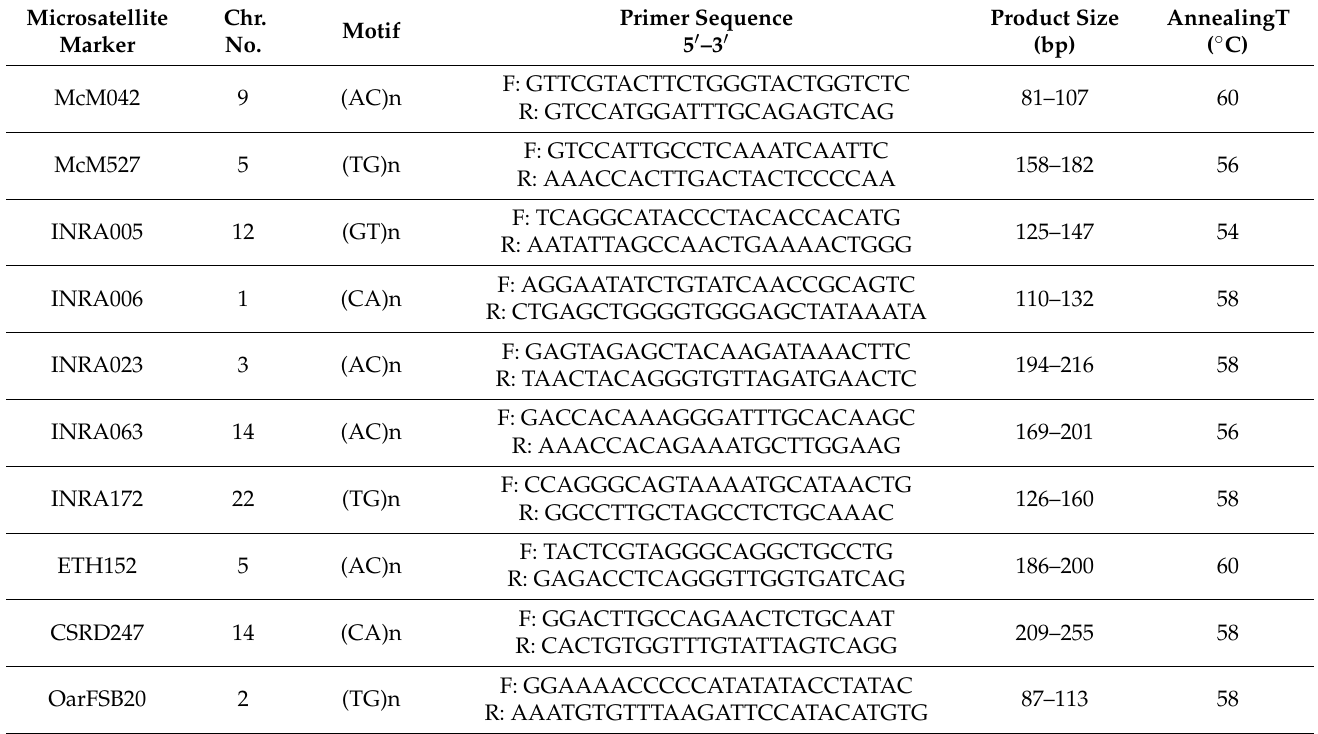
Table 1. Details of the used ovine microsatellite (STR)